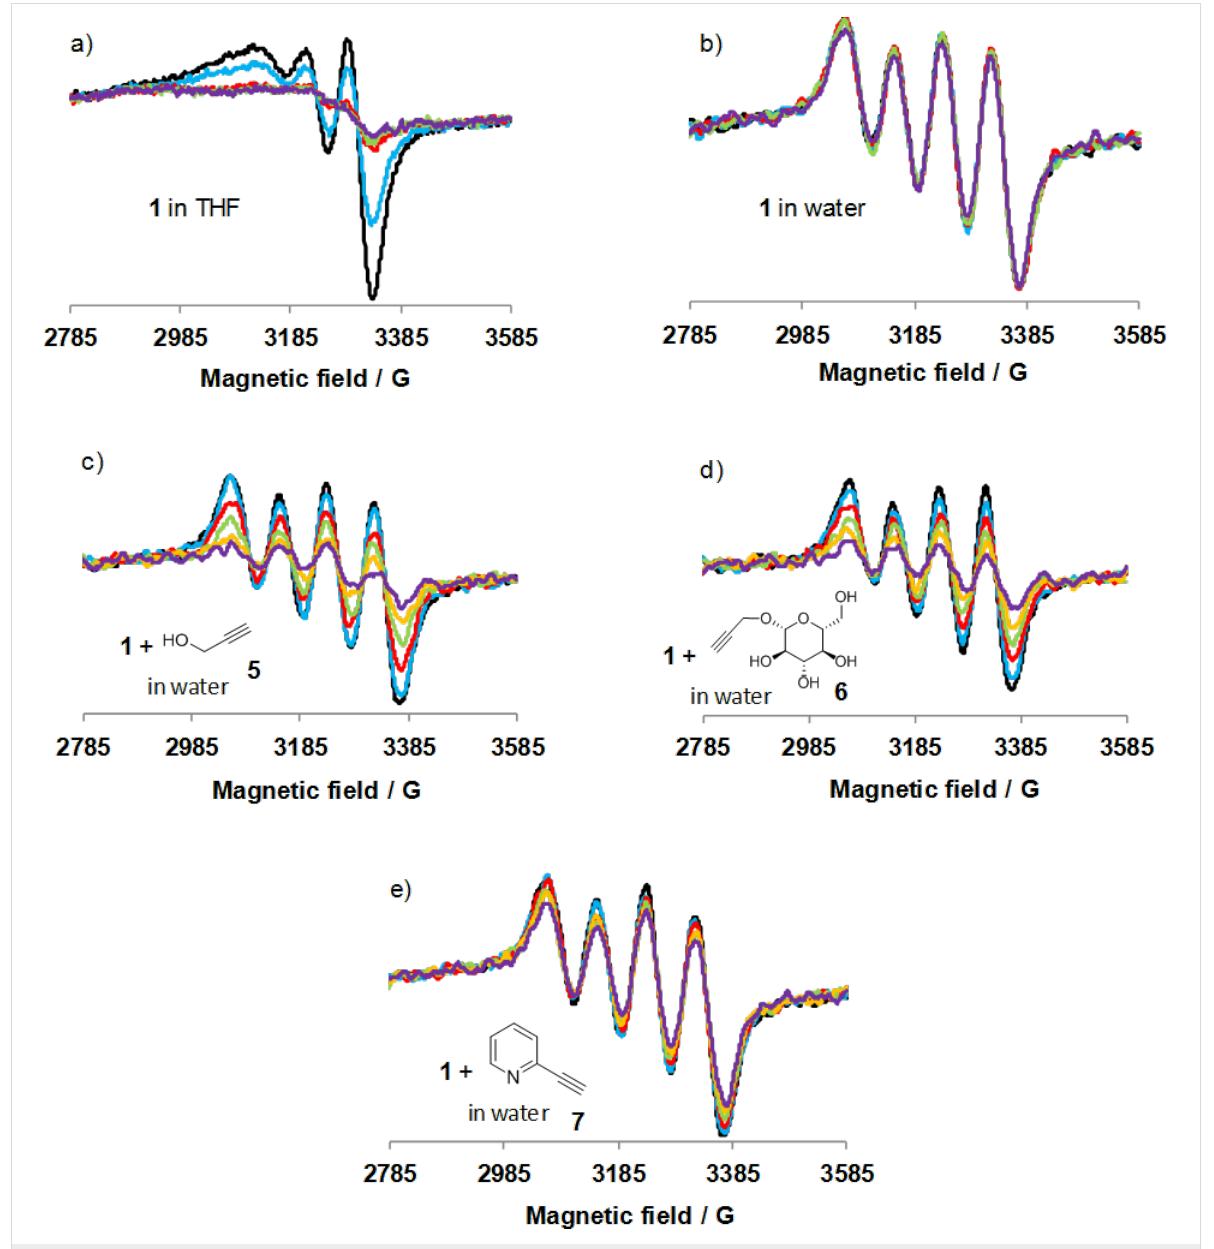
Figure 3: Evolution of the EPR spectra (X band, 298 K) of solutions of 1 under continuous irradiation (280–400 nm). A spectrum is recorded in the dark (black), then the light is switched on and the spectra (scanning time = 15 s) recorded during irradiation at times 0 s (blue), 50 s (red), 100 s (green), 150 s (orange) and 225 s (purple). a) THF solution of 1 (1 mM); b) H 2 O solution of 1 (1 mM); c) H 2 O solution of 1 (1 mM) and alkyne 5 (50 mM); d) H 2 O solution of 1 (1 mM) and alkyne 6 (50 mM); e) H 2 O solution of 1 (1 mM) and alkyne 7 (50